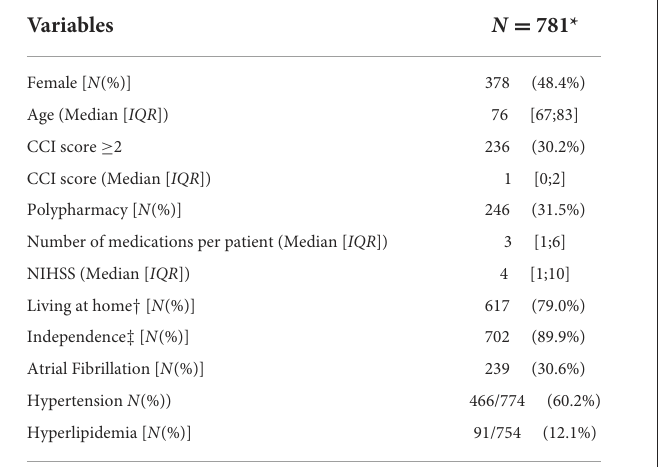
TABLE 1 Patient characteristics at